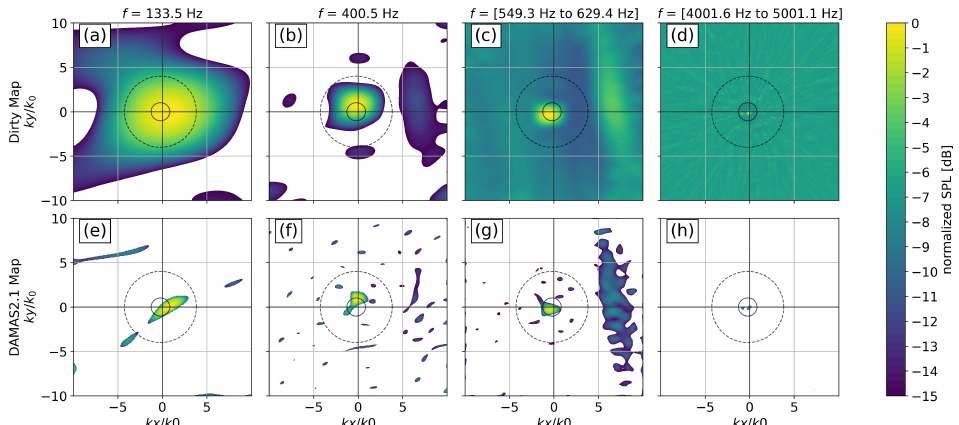
Figure 15. Wavenumber dirty maps and deconvolved maps at selected frequencies, plotted with a dynamic range of 15 dB. The acoustic domain is shown as a solid circle in the center of the map. The expanded integration border for separation of acoustic and other types of pressure fluctuations is shown as a dashed line surrounding the acoustic domain. ( a )/( e ): narrow band dirty map/deconvolved map at 133.5 Hz; ( b )/( f ): narrow band dirty map/deconvolved map at 400.5 Hz; ( c )/( g ): integrated dirty maps/deconvolved maps from 549.3 Hz to 629.4 Hz; ( d )/( h ): integrated dirty maps/deconvolved maps from 4001.6 Hz to 5001.1